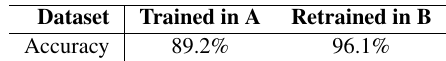
Table 3. Accuracy of the classifier trained in train set of A, and evaluated in Test set of A and B.